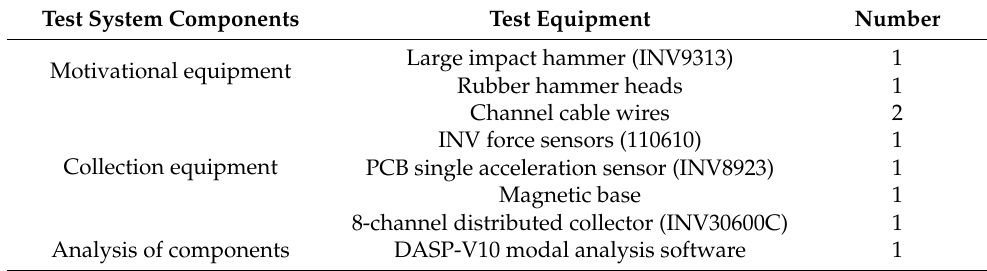
Table 7. Main characteristics of the equipment for the modal test of the STTGB deck.